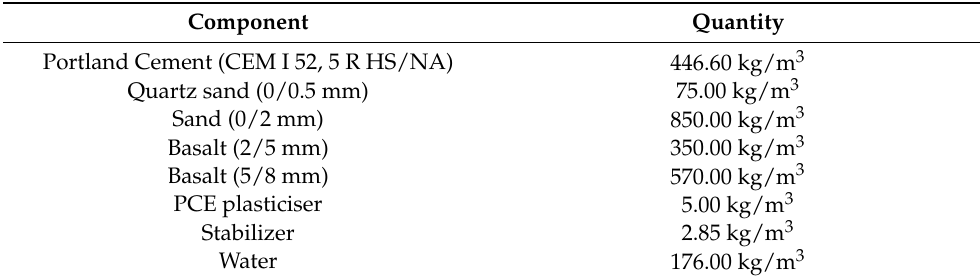
Table 1. Composition of the investigated concrete RH1-B.